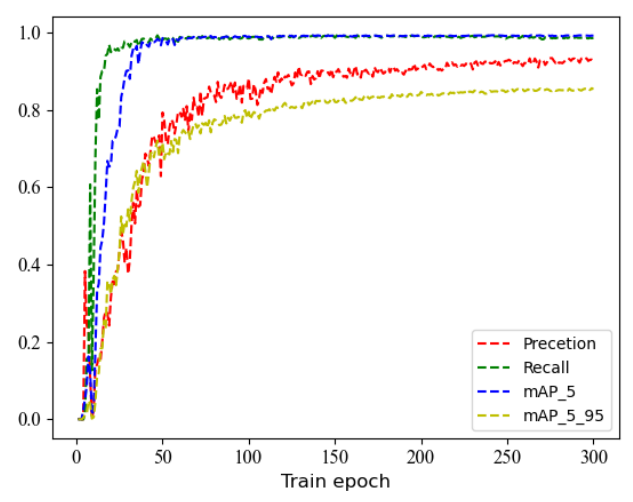
Figure 12. Training